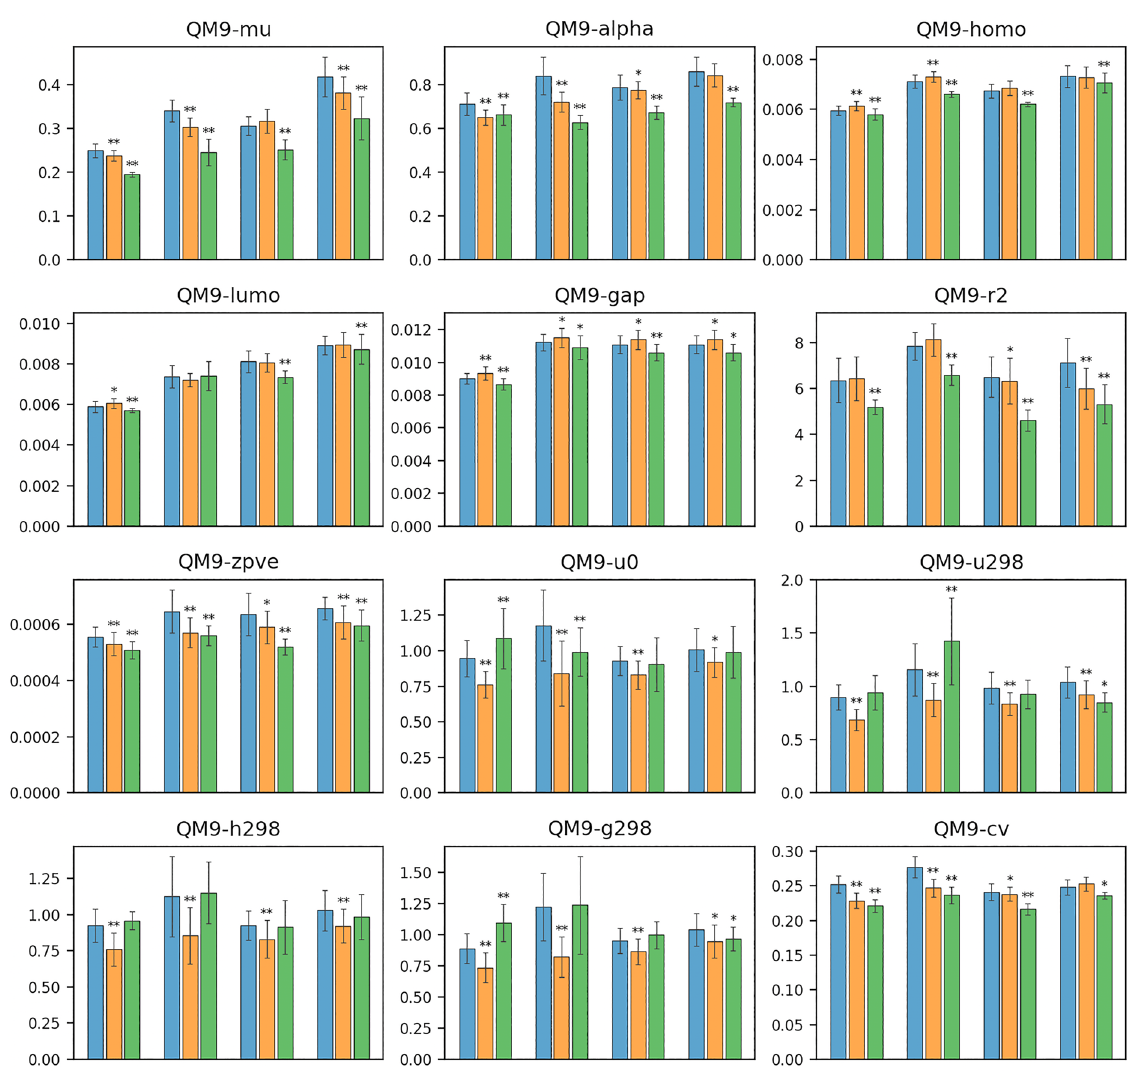
Figure 2. MAE comparison results of QM9. The 12 subplots correspond to 12 property prediction tasks. The x-axises correspond to the four simulated biased sampling scenarios. The blue, orange, and green bars correspond to the Baseline, IPS, and CFR approaches,